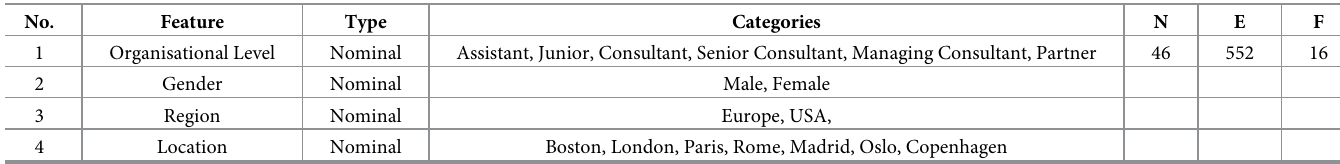
Table 5. The Consulting Organisational Social Network data